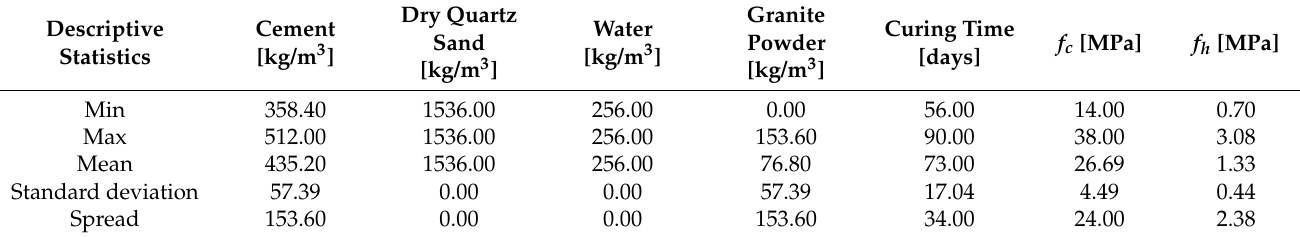
Table 2. Range of input and output